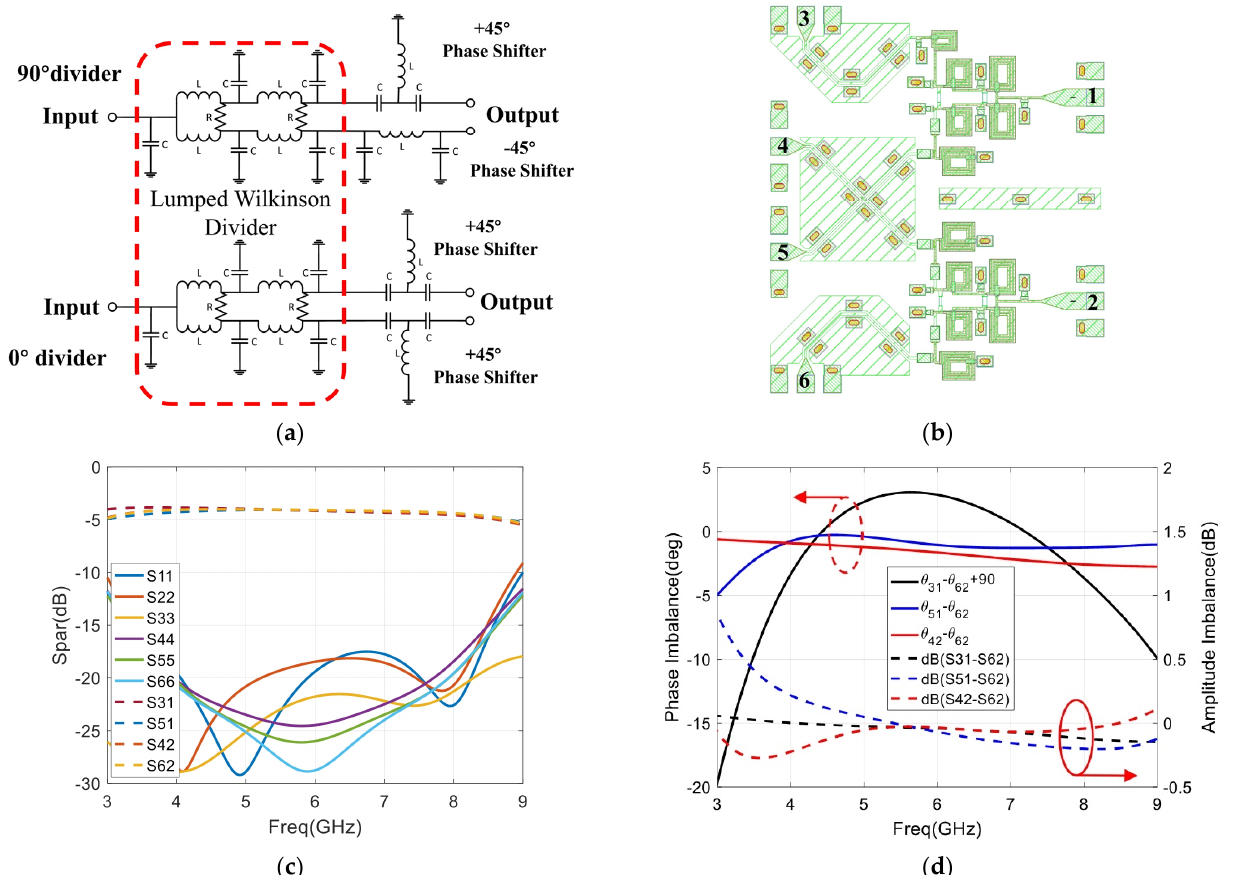
Figure 4. The schematic, layout design, and simulation result of the designed integrated divider chip: ( a ) Schematic of 0° and 90° divider chips; ( b ) Layout design of the divider chip; ( c ) S-parameter simulation results of the divider chip; ( d ) S-parameter simulation results of the divider chip.